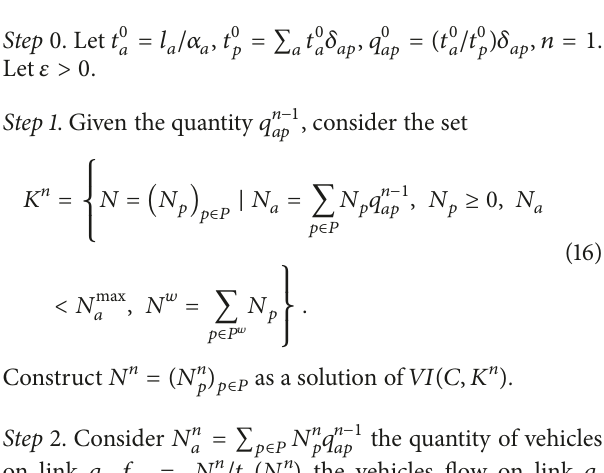
Algorithm 4. We construct the sequence (𝑁 ing